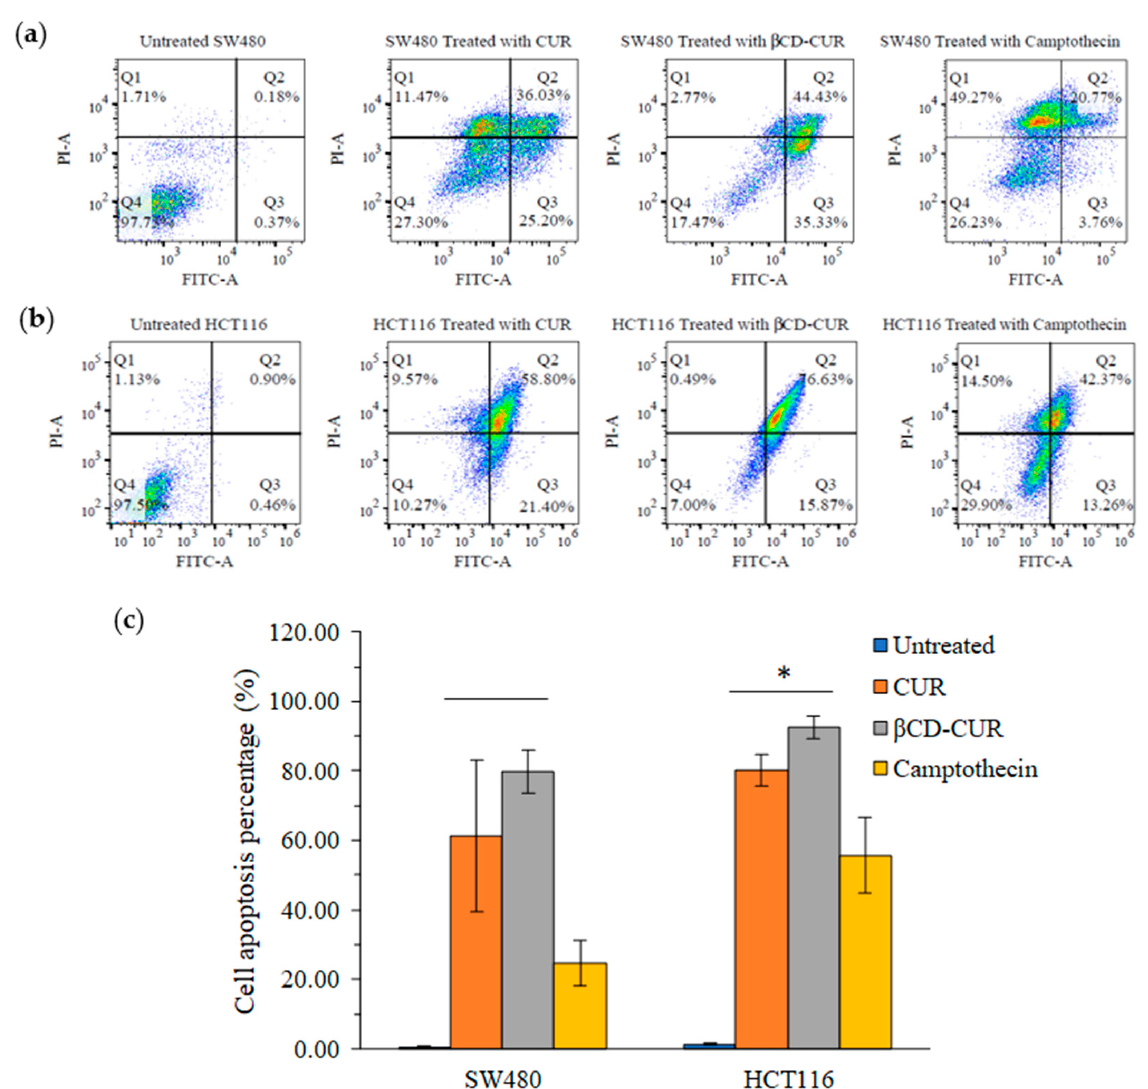
Figure 7. Annexin V/FITC-PI flow cytometry analysis of SW480 and HCT116 cells treated with negative control, CUR, β CD-CUR, and camptothecin for 24 h. Cells were dual stained with Annexin V-FITC (FITC) and propidium iodide (PI). ( a ) Dot plot of SW480 with different treatments. ( b ) Dot plot of HCT116 cells with different treatments. Each set of data shown was a representative plot of three independent experiments, while percentages were the mean value of three independent experiments. Q1, necrosis; Q2, late apoptosis; Q3, early apoptosis; Q4, viable cell. ( c ) The quantification of apoptotic rate on both cell lines. Data are presented as the mean ± S.D. ( n = 3). * Significantly different, p < 0.05. The induction of apoptosis-mediated cell death was confirmed using proteolytic PARP cleavage assays where full-length PARP (116 kDa) was cleaved into a large 89 kDa fragment through caspase-3 activity (Figure 8). As seen in Figure 8a, the Western blot image was represented for SW480 cells, whereas HCT116 cells were shown in Figure 8b. β -actin was used as a loading